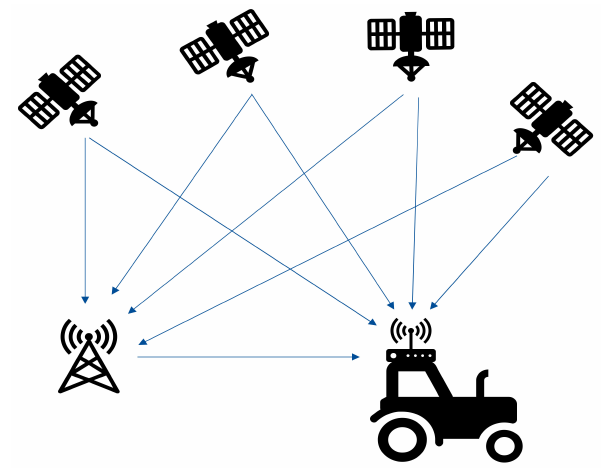
Figure 1. RTK working